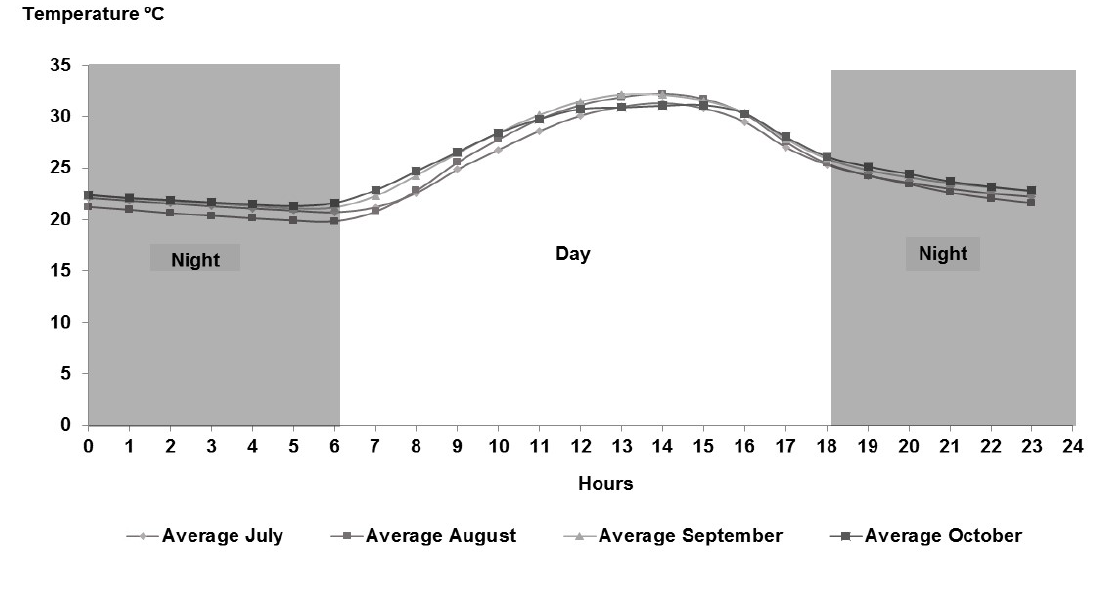
Figure 4: Average day and night temperatures during the growing season in San Ramon